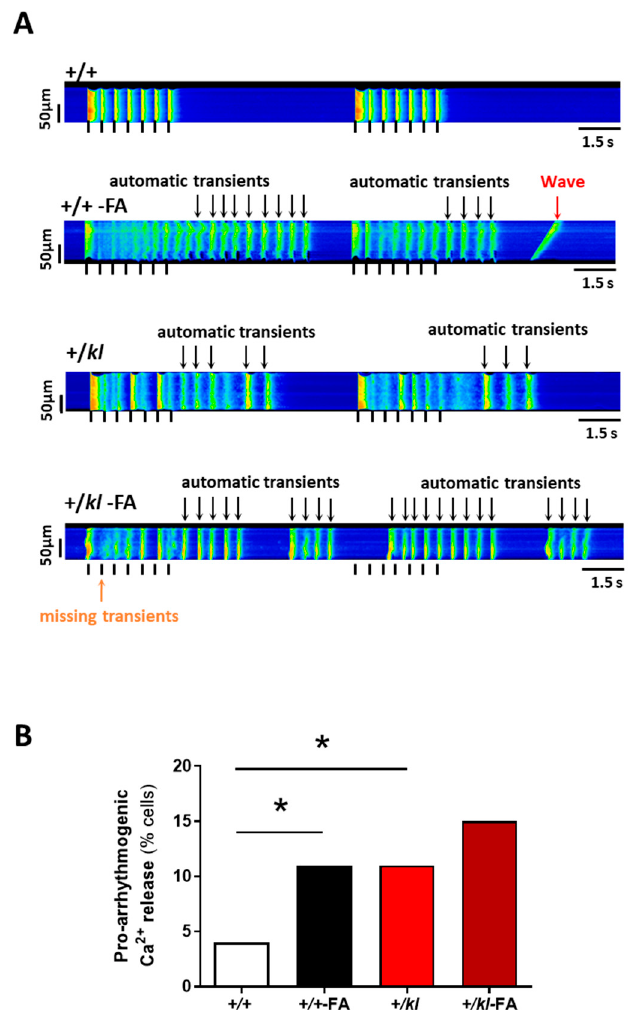
Figure 6. Partial Klotho deficiency increases pro-arrhythmogenic Ca 2+ events similarly to those observed after AKI. ( A ) Representative line-scan images of cardiomyocytes from each experimental group. Cardiomyocytes were electrically stimulated at 2 Hz in seven-pulse sequences. Black arrows represent automatic Ca 2+ transient events, the red arrow represents the automatic Ca 2+ wave and the orange arrow represents missing Ca 2+ transients (no contraction of the cardiomyocytes during stimulation). ( B ) Quantification of these proarrhythmogenic Ca 2+ releases following the arrhythmia protocol in cardiomyocytes from +/+ (n = 53 cells, N = 5 mice), +/+-FA (n = 107 cells, N = 4 mice), +/ kl (n = 51 cells, N = 5 mice) and +/ kl -FA mice (n = 85 cells, N = 3 mice). Data are expressed as percentage of cells with abnormal behaviour of continuous variables after Fisher test. * p < 0.05 vs.